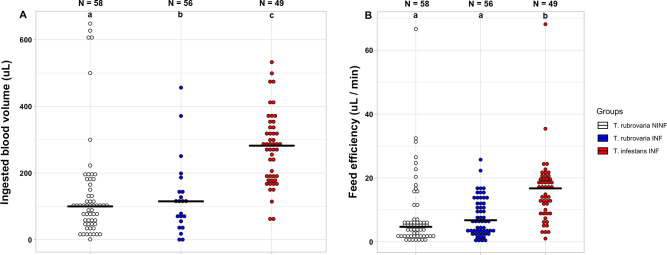
Feeding parameters of non-infected T. rubrovaria (NINF), and infected T. rubrovaria (INF) and T. infestans (INF)–ingested blood volume (A) and feeding efficiency (B). The number of samples analyzed for each condition is shown above each dotplot column. Different lowercase letters indicate statistically significant differences (Wilcoxon-Mann-Whitney W-test; A: p (ab) < 0.05, p (bc and ac) < 0.0001; B: p (ab) < 0.0001.